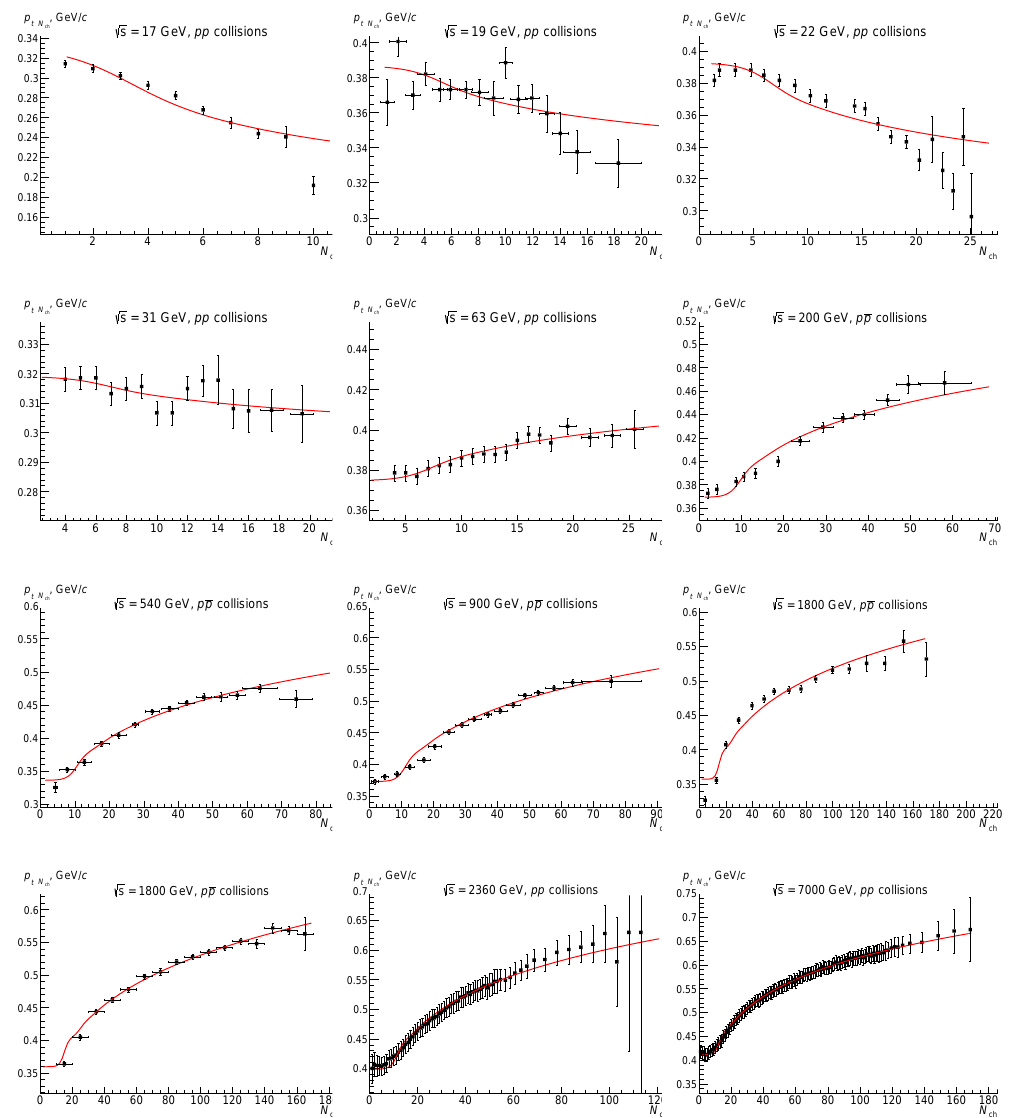
Figure 4. Experimental data on the (cid:104) p t (cid:105) - N ch correlation at several energies in pp and p ¯ p collisions fitted by the present model [14]. We took the experimental data from